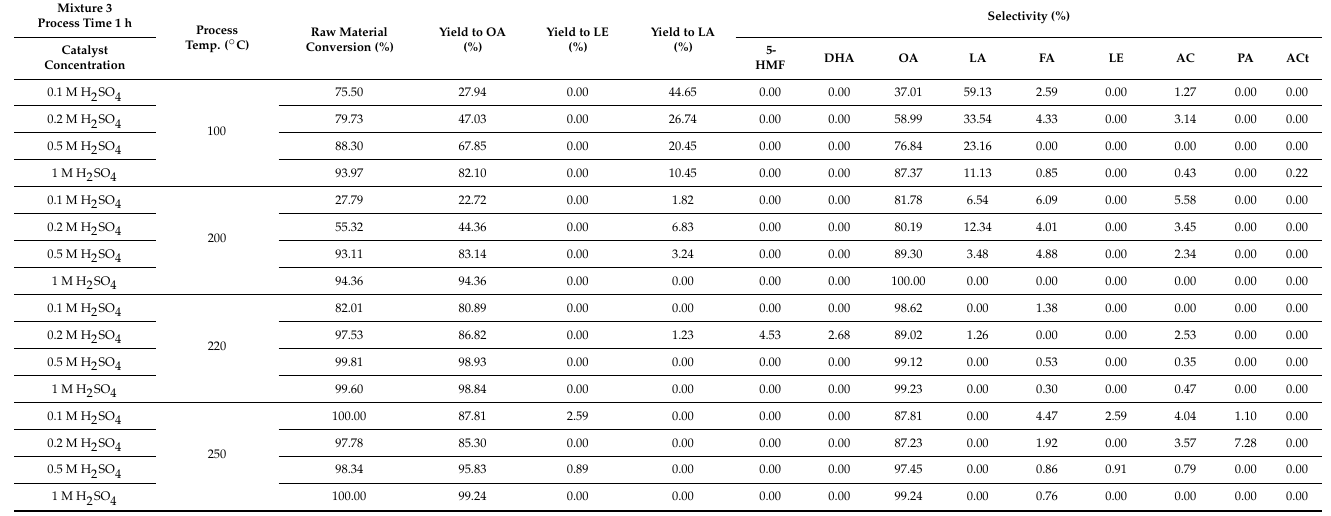
Table 3. The results of HPLC analysis for the catalytic conversion of hemicellulose carbohydrates using the homogeneous H 2 SO 4 catalyst in the liquid phase, with a 1 h process time for mixture